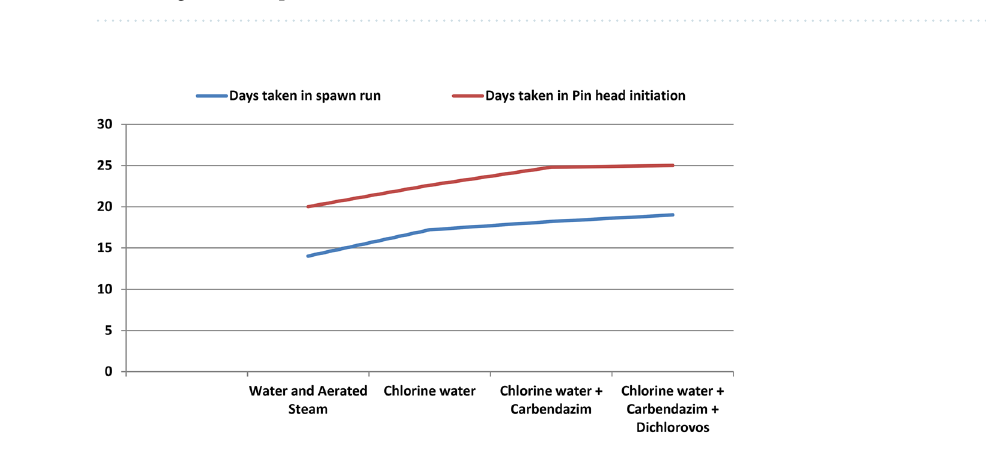
Figure 5. Average number of days taken in spawn run completion and average number of days taken for pin head initiation on substrates treated with different sterilization